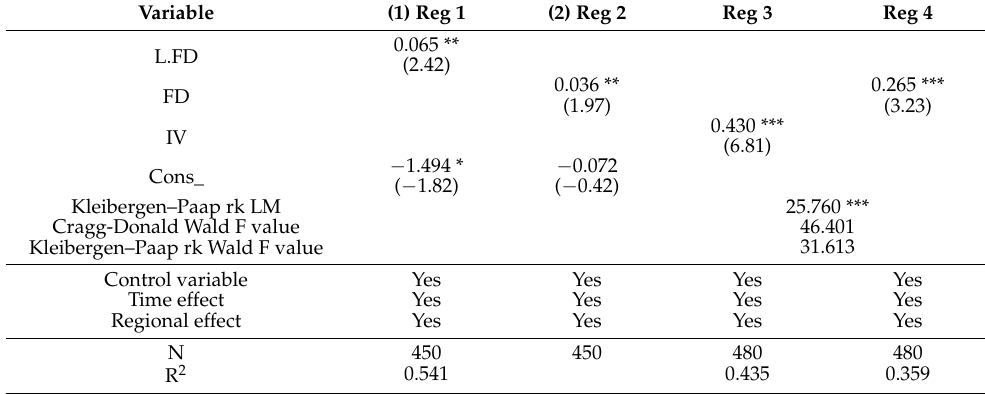
Table 5. Regression results of endogenous